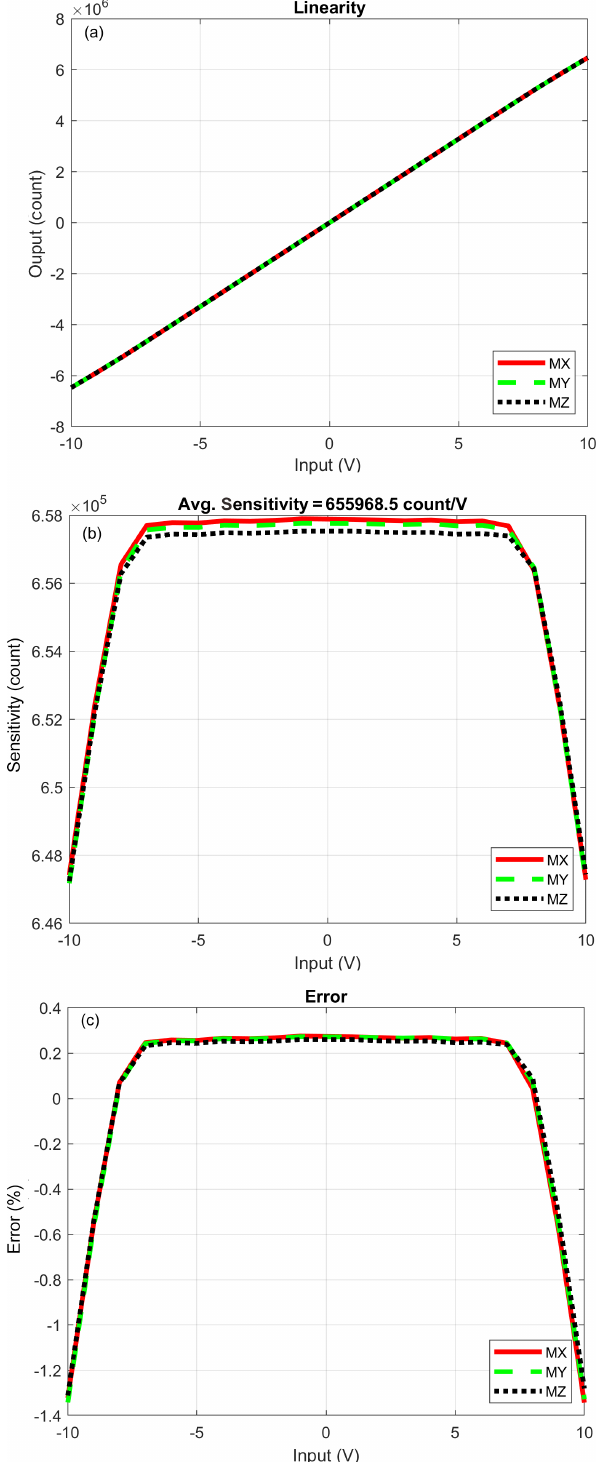
Figure 4. Calibration results for the magnetic channels of the OBEM01. (a) Linearity, (b) sensitivity and (c) error. The aver- age sensitivity is 655968.5countsV − 1 , and the maximum error is <